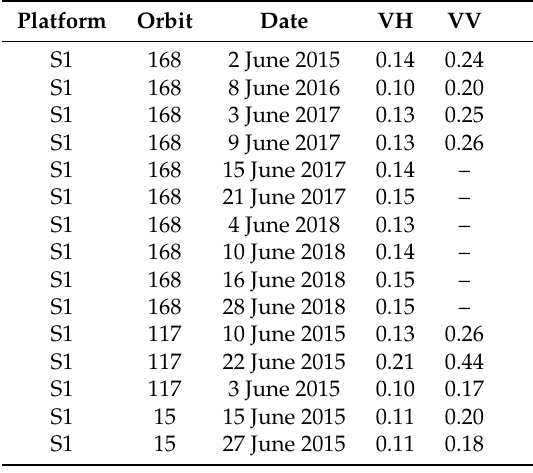
Table 3. Determined coefficients of variation for all acquired Sentinel-1 scenes in June between 2015–2018. Respective orbits are described in Table